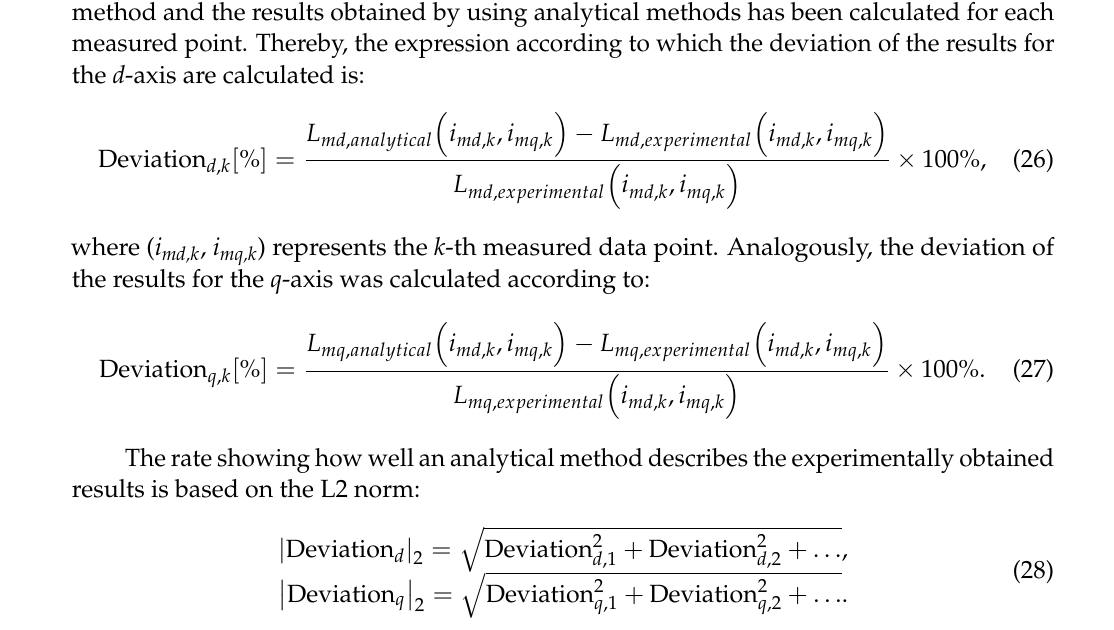
Table 2. Calculated L2 norms for the deviations between the experimentally and analytically ob- tained results.